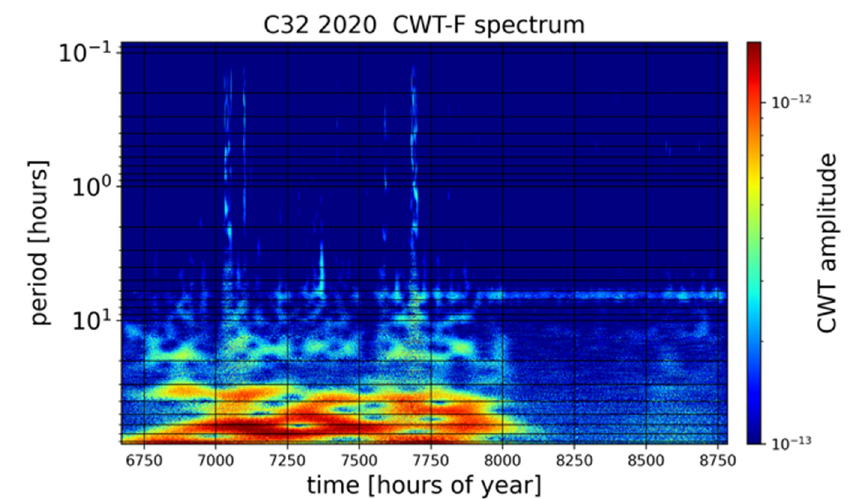
Figure 6. CWT spectrogram for the C32 satellite.